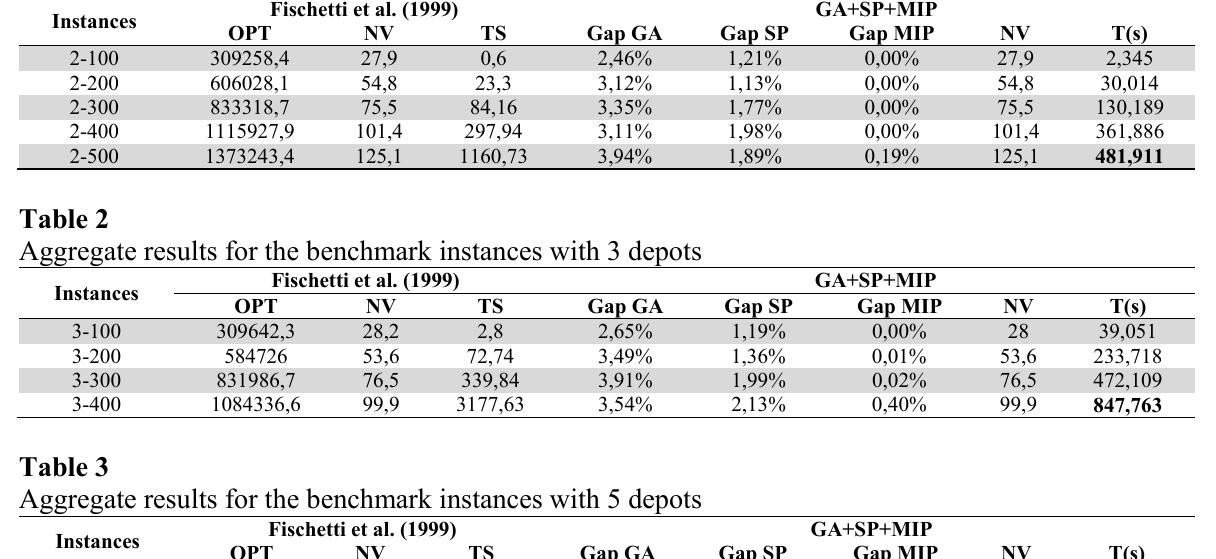
Consolidated (average) of instances groups with 2 depots Instances